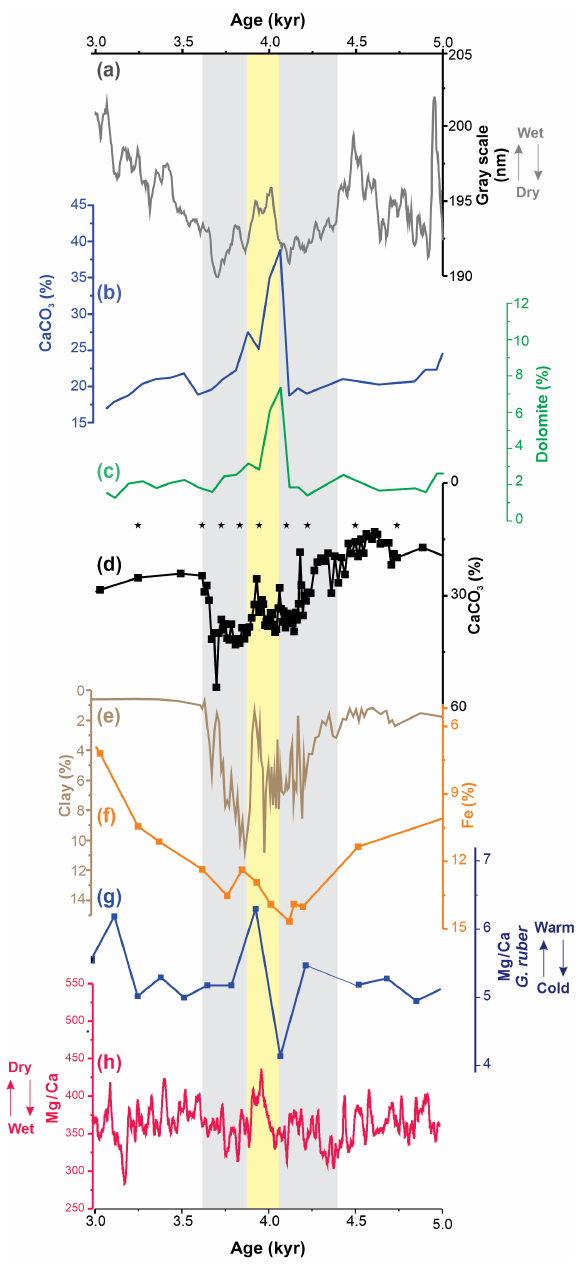
Figure 6. Geochemical records from Lagoa Salgada in compar- ison with other climate records. (a) Gray scale (nm) from Cari- aco Basin, Venezuela (Hughen et al., 1996); (b) Carbonate content (CaCO 3 ) (%) and (c) dolomite (%) from the Gulf of Oman (Cullen et al., 2000); (d) Carbonate content (CaCO 3 ) (%), (e) clay (%), and (f) Fe (%) from this study; (g) Mg / Ca, Globigerinoides ruber , from the southwest Brazilian coast (Lessa et al., 2016) and (h) Mg / Ca speleothem from Botuvera Cave, southwestern Brazil (Bernal et al., 2016). The nine black stars indicate the position of the radiocarbon dates measured in this study. The gray bar emphasizes the period between 4.3 and 3.6kyr (wet condition) and the yellow bar shows the 4.2ka event (dry